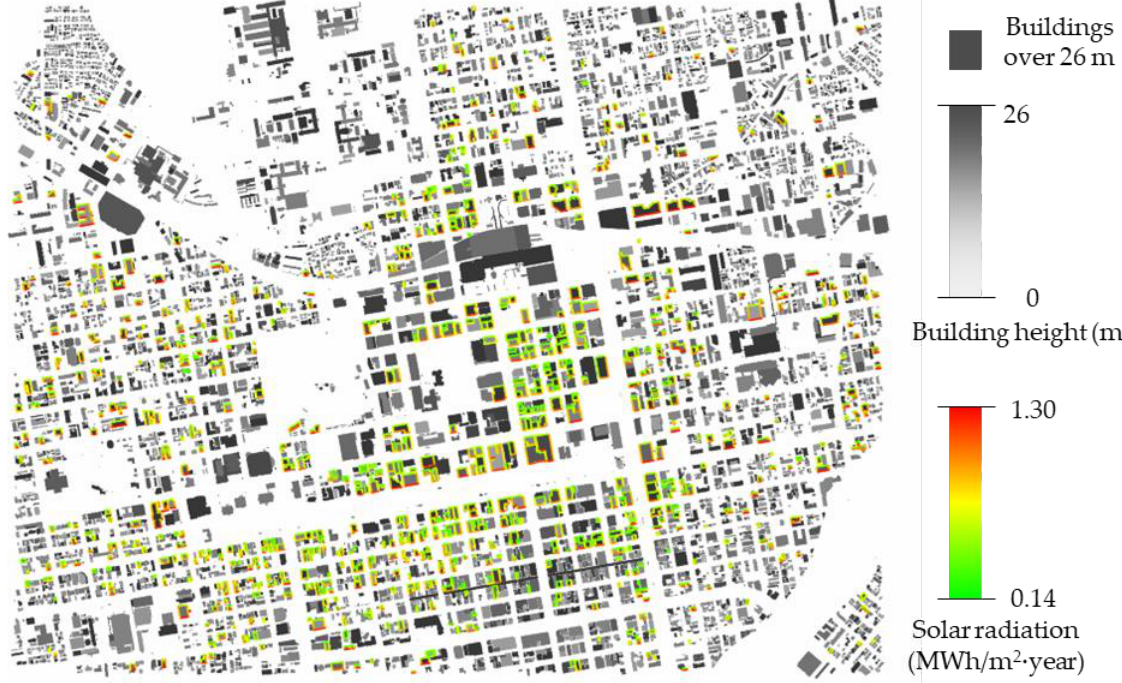
Figure 7. Distribution of solar radiation in Area-A.